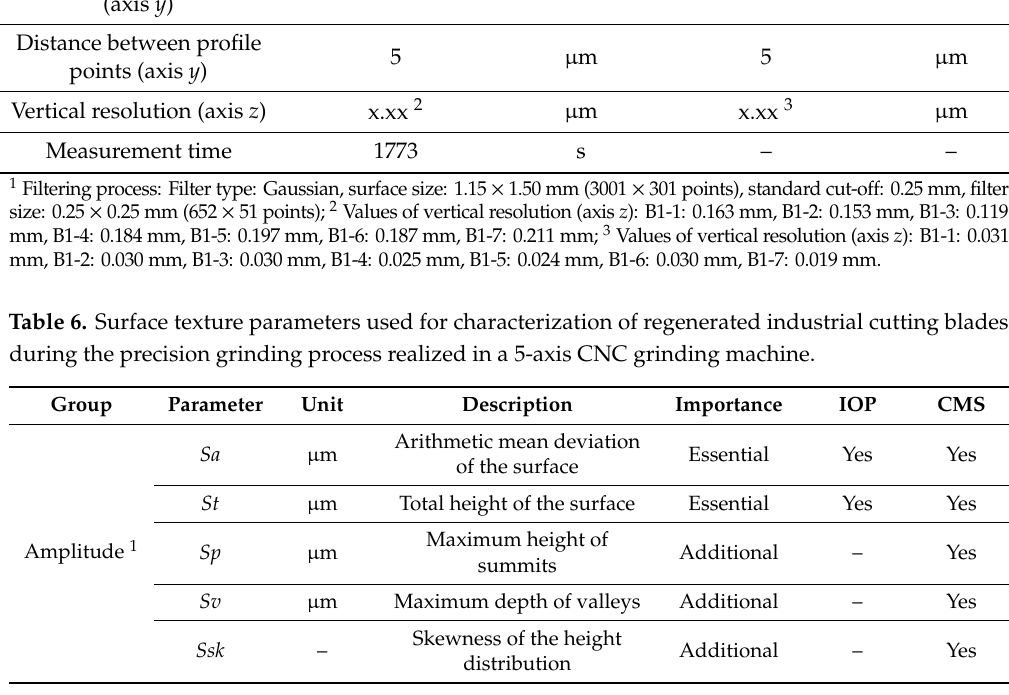
1 Filtering process: Filter type: Gaussian, surface size: 1.15 × 1.50 mm (3001 × 301 points), standard cut-off: 0.25 mm, filter